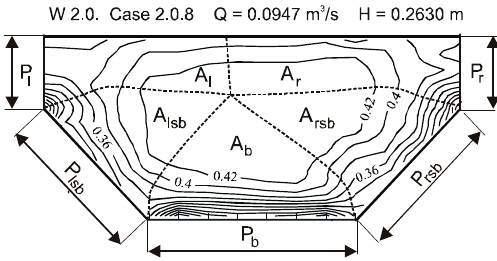
Figure 5. Surface areas of stream cross-sections A i in which the flow conditions are shaped under the influence of a constant roughness over the length of the wetted perimeter P i .